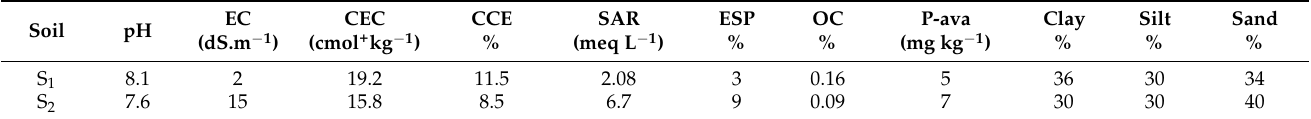
Table 5. Physical and chemical properties of the